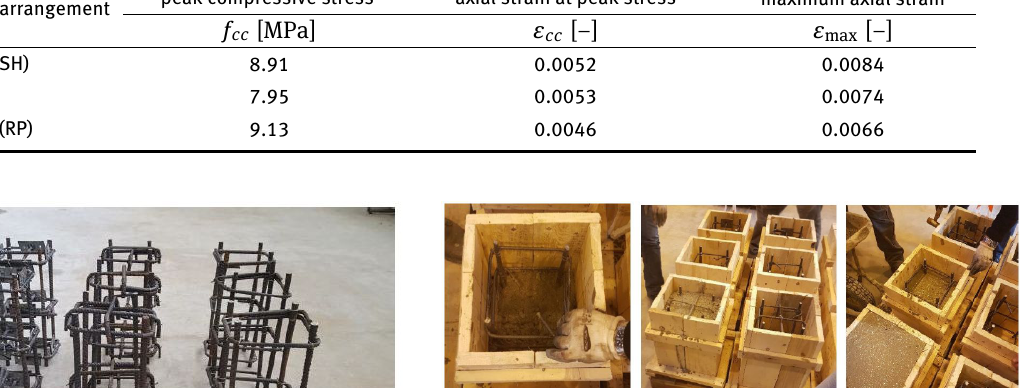
reinforcement arrangement